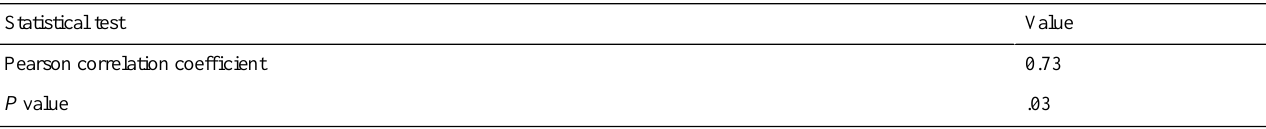
ValueStatistical